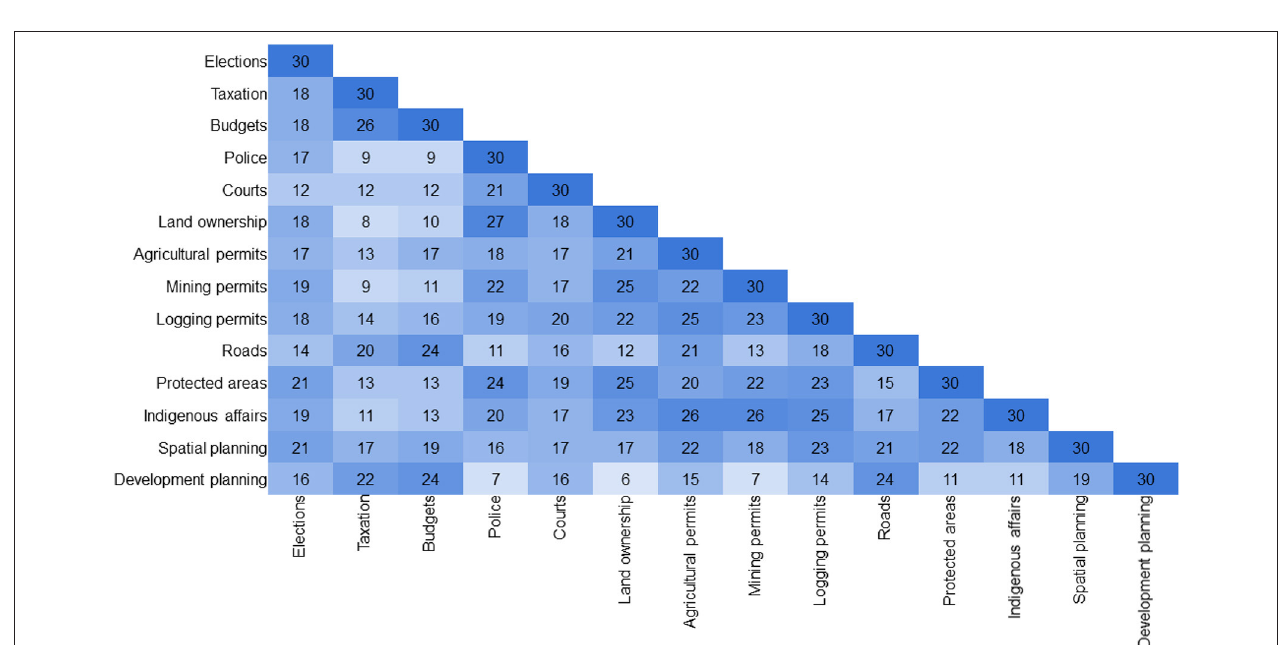
FIGURE 4 | Number of countries (out of 30) with the same score for both authorities, for each pair of authorities.